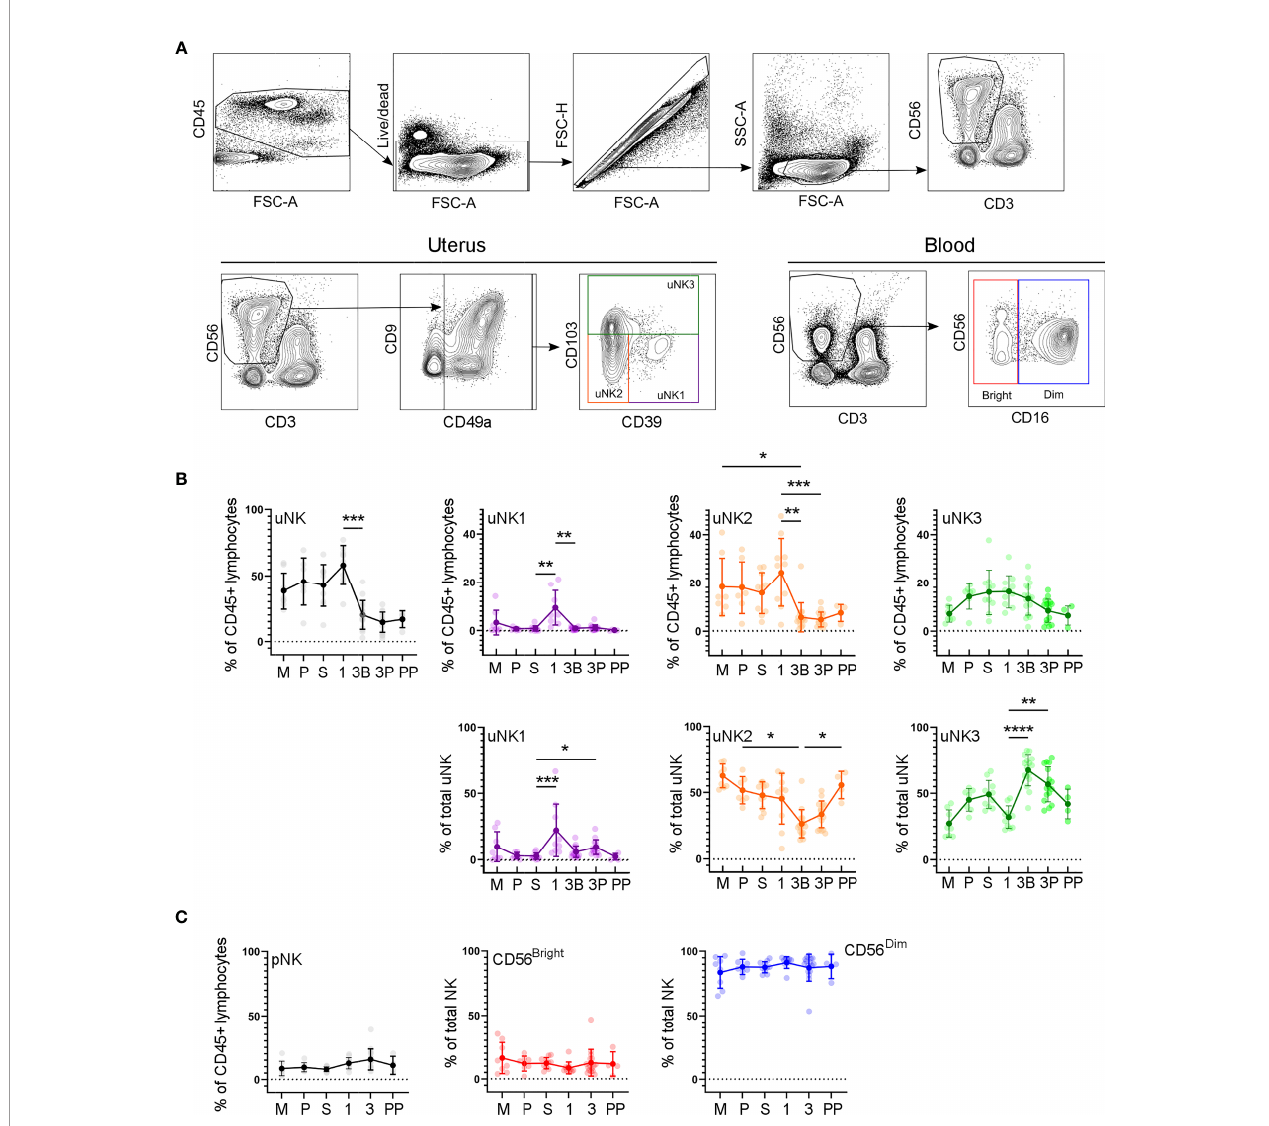
FIGURE 2 | uNK1, -2 and -3 are present throughout the human reproductive cycle, by fl ow cytometry. (A) FACs gating strategy used to identify three uNK subsets and pNK (representative example shown). Coloured boxes in fi nal plot indicate colour used for that subset in subsequent graphs. (B) Using fl ow cytometry data, graphs show frequency of total NK from CD45+ lymphocytes and then frequency of each uNK subset (uNK1, -2 -3) both as a proportion of CD45+ lymphocytes and proportion of total uNK cells. Means and standard deviations are shown for n = 8 (menstrual), n = 7 (proliferative), n = 10 (secretory) n= 10 ( fi rst trimester), n= 16 (third trimester decidua basalis), n = 16 (third trimester decidua parietalis), n = 4 (postpartum). Statistical testing was done using Kruskal Wallis with a post-hoc Dunn test *p < 0.05, **p < 0.01, ***p < 0.001, ****p< 0.0001. (C) Using fl ow cytometry data, graphs show frequency of total NK from CD45+ lymphocytes and then frequency of each pNK subset (CD56 Bright and CD56 Dim ) as a proportion of total pNK. Sample numbers for each group are the same as B. M, menstrual phase; P, proliferative phase; S, secretory phase; 1, fi rst trimester; 3B, third trimester decidua basalis; 3P, third trimester decidua parietalis; PP,